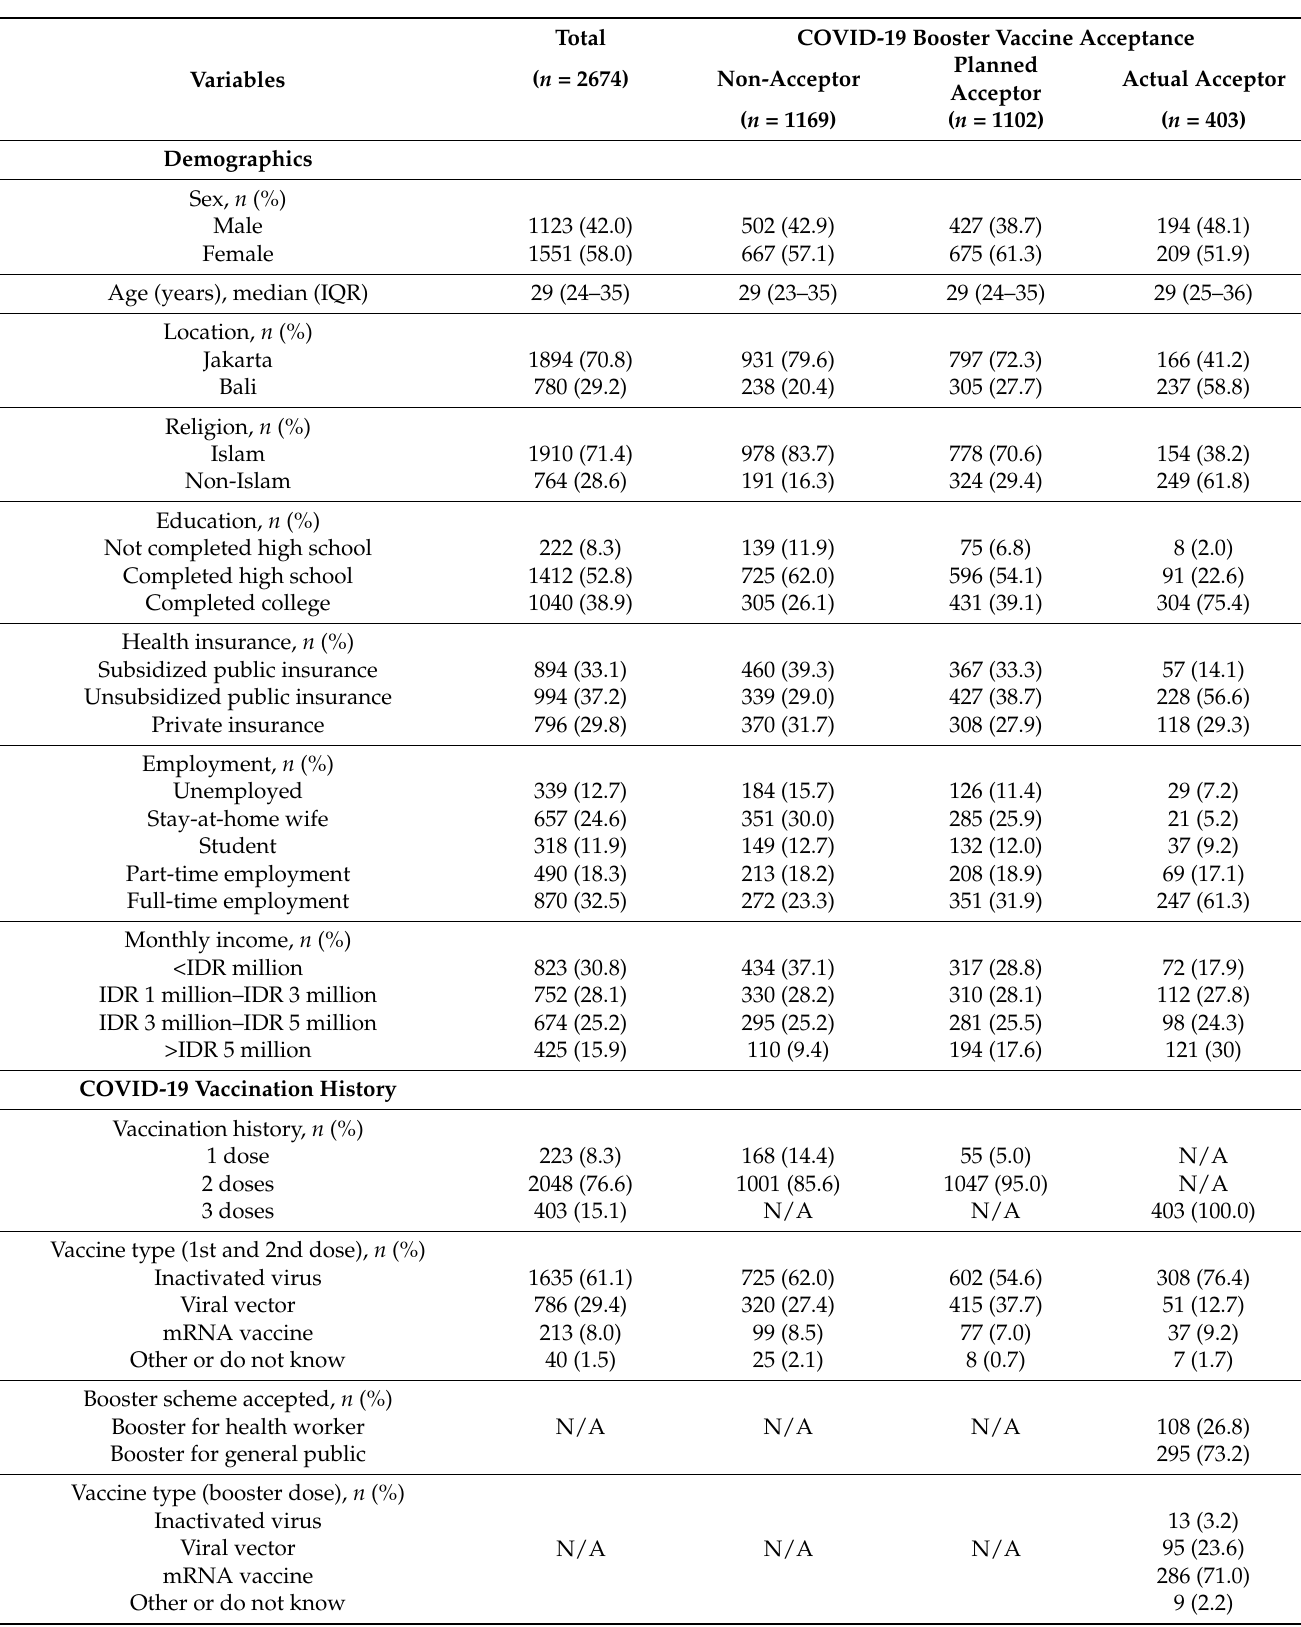
Table 1. Demographic, COVID-19 infection, and vaccination history characteristics of